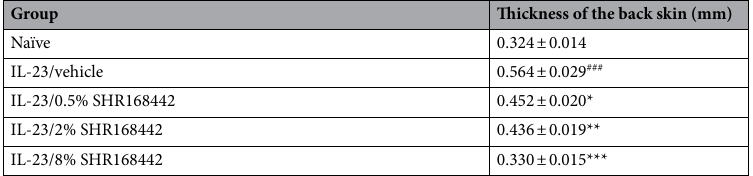
Table 3. Effects of SHR168442 in Vaseline via topical route in skin thickness of mice induced by IL-23 (Mean ± SEM, n = 10). Data were analyzed by one-way ANOVA. ### p < 0.001 versus naïve group. * p < 0.05, ** p < 0.01, *** p < 0.001 versus IL-23/vehicle group.